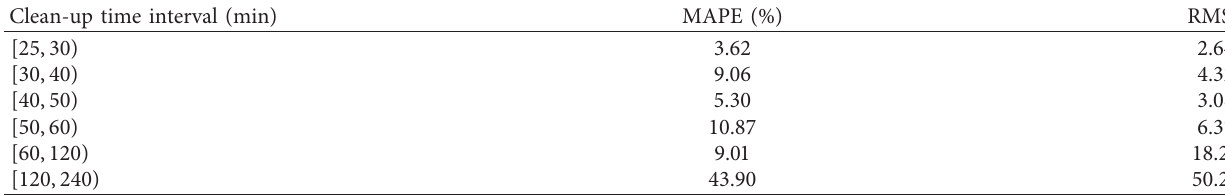
Table 7: MAPE and RMSE in clean-up time intervals.